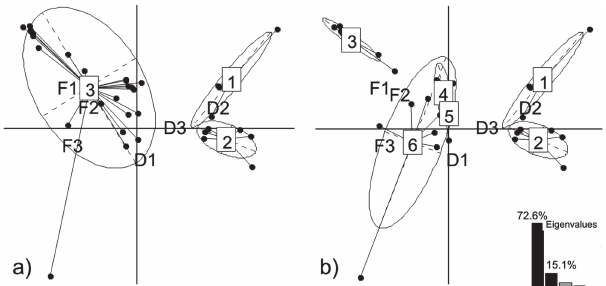
Fig. 4. Double Principal Coordinate Analysis (DPCoA) biplot ordination, describing the functional differences between forested (F1-F3) and deforested (D1-D3) streams. Black circles indicate each species, and their relative positions reflect their functional dissimilarities. Species are linked according to the functional groups originating from partitions #33 (a) and #30 (b). Species identities and their functional traits are shown in Fig. 3.